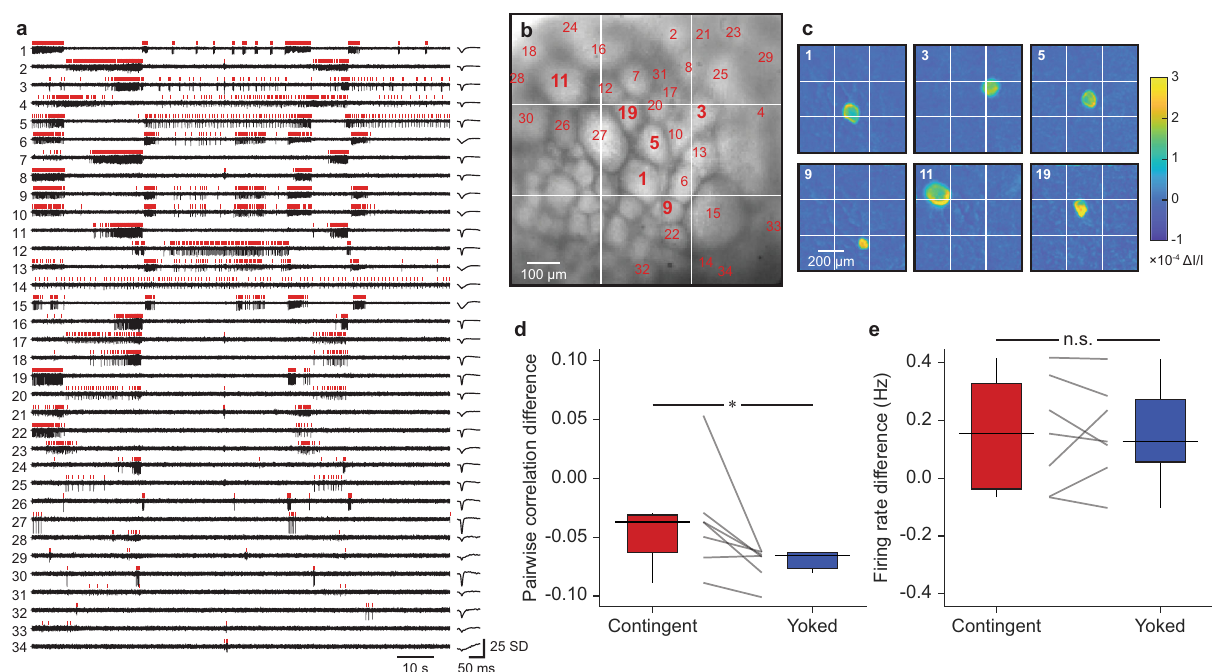
Fig. 2 VSD imaging captures changes in primary features of population activity. a Z -scored light intensities of neurons (left, black) and average waveform of detected action potentials (right). Red vertical lines indicate spike times. Neurons that had at least fi ve spikes during the 120-s recording period are displayed (34 out of 92 neurons). b Imaged ganglion. Numbers correspond to neuron IDs of the cells in panels a and c . c Localized changes in light intensity during action potentials. Each panel displays the average change in intensity from baseline to peak across all detected spikes in the cell. Neuron ID is shown on the top-left of each panel. d Contingent training led to higher pairwise correlation across the population than yoked training ( P = 0.03, W = − 26, N = 7; medians: contingent = − 0.04, yoked = − 0.07). e No signi fi cant difference was observed in overall fi ring rate across the population ( P = 0.81, W = − 4, N = 7; medians: contingent = 0.15, yoked = 0.13). Data were pretest-subtracted. Individual datums represent preparations. Box plots show median (line), quartiles (box), and range